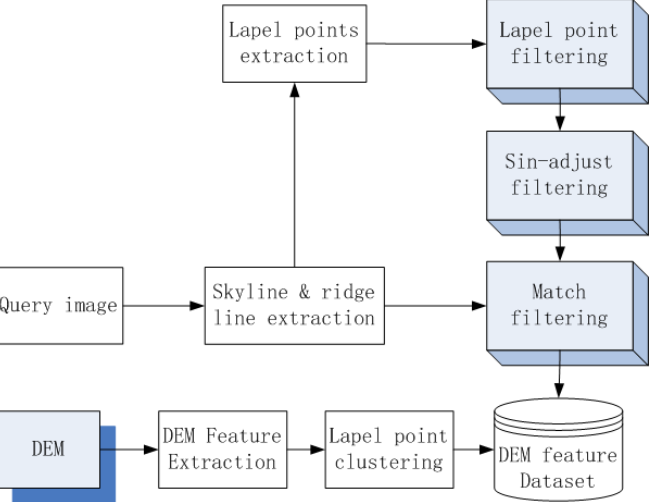
Figure 9. The flow chart of the proposed